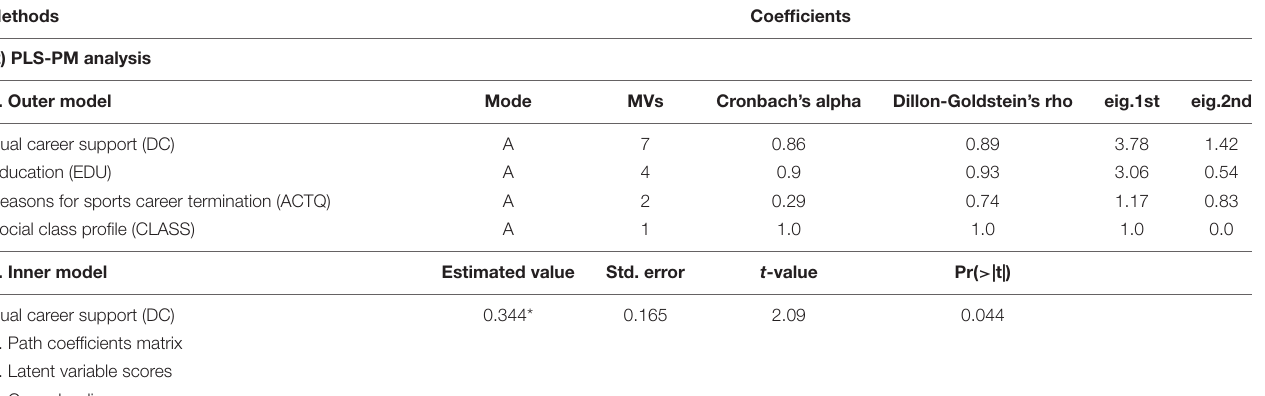
TABLE 4 | Partial least squares path modeling (PLS-PM) coefficients and analysis.